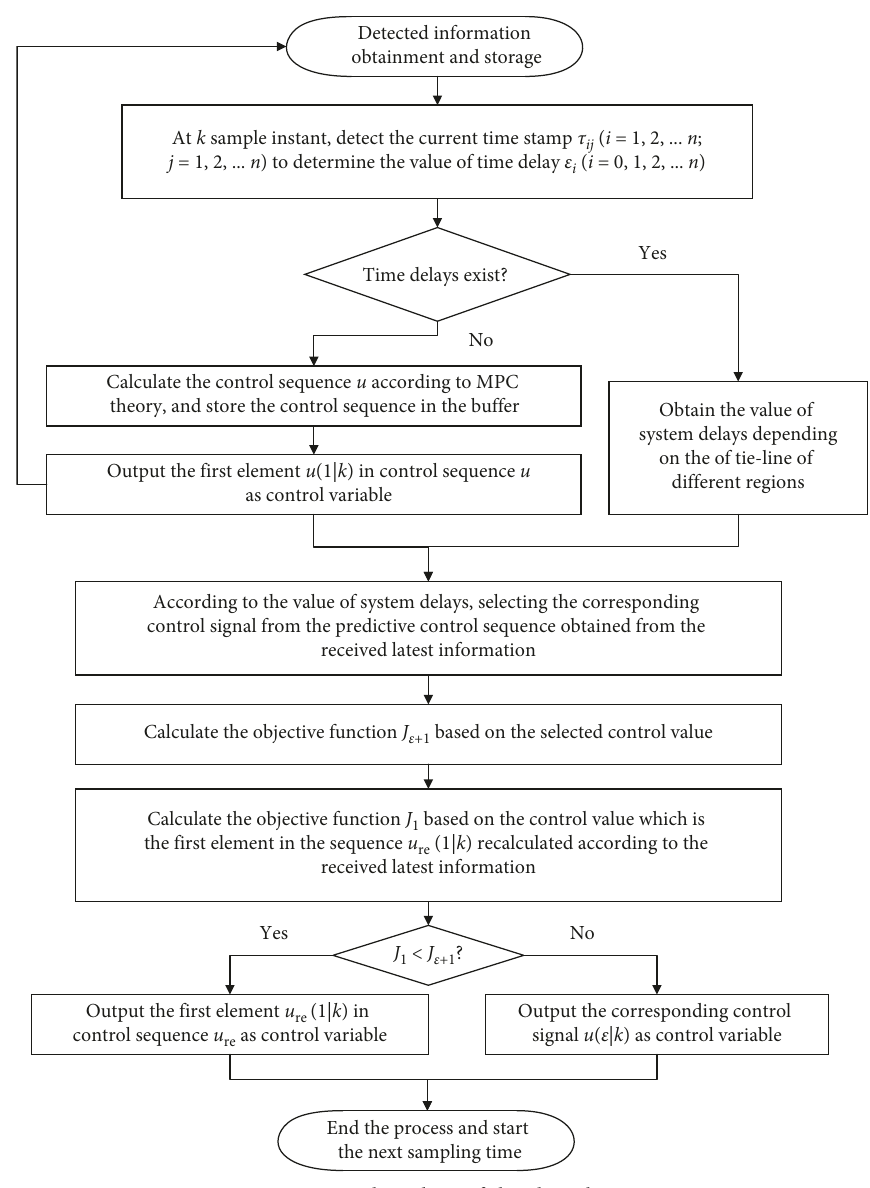
Figure 6: Flow chart of the